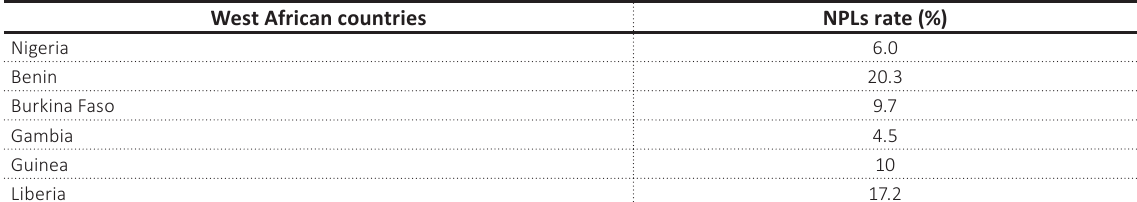
Table 1. Summary of NPLs rate in